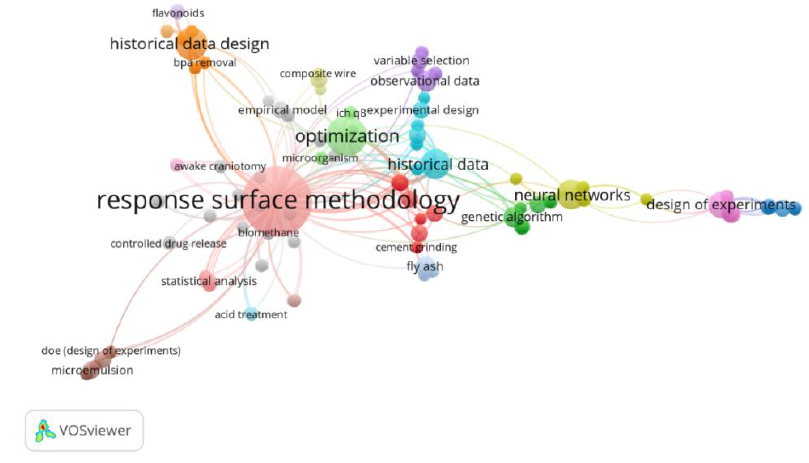
Figure 7. Graphical network of bibliometric analysis. Table 3. Occurrences and link strength of graphical keyword networks in Figure 8.